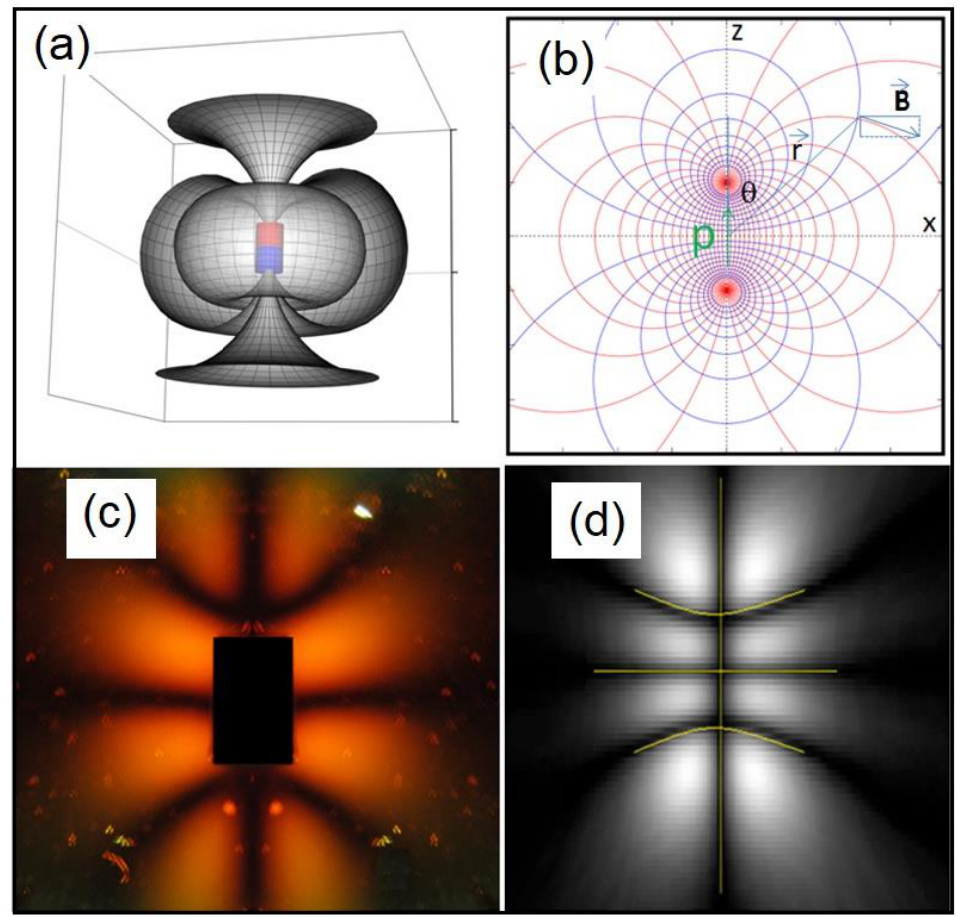
Figure 1. ( a ) Diagram of the magnetic field around a magnetic dipole. ( b ) Magnetic dipole diagram in the xz plane, with its respective dipole coordinate system. ( c ) Example of a luminous pattern of polarization of light in a Ferrocell witha magnetic dipole. ( d ) Diagram of a luminous pattern with isogyres marked with yellow lines.